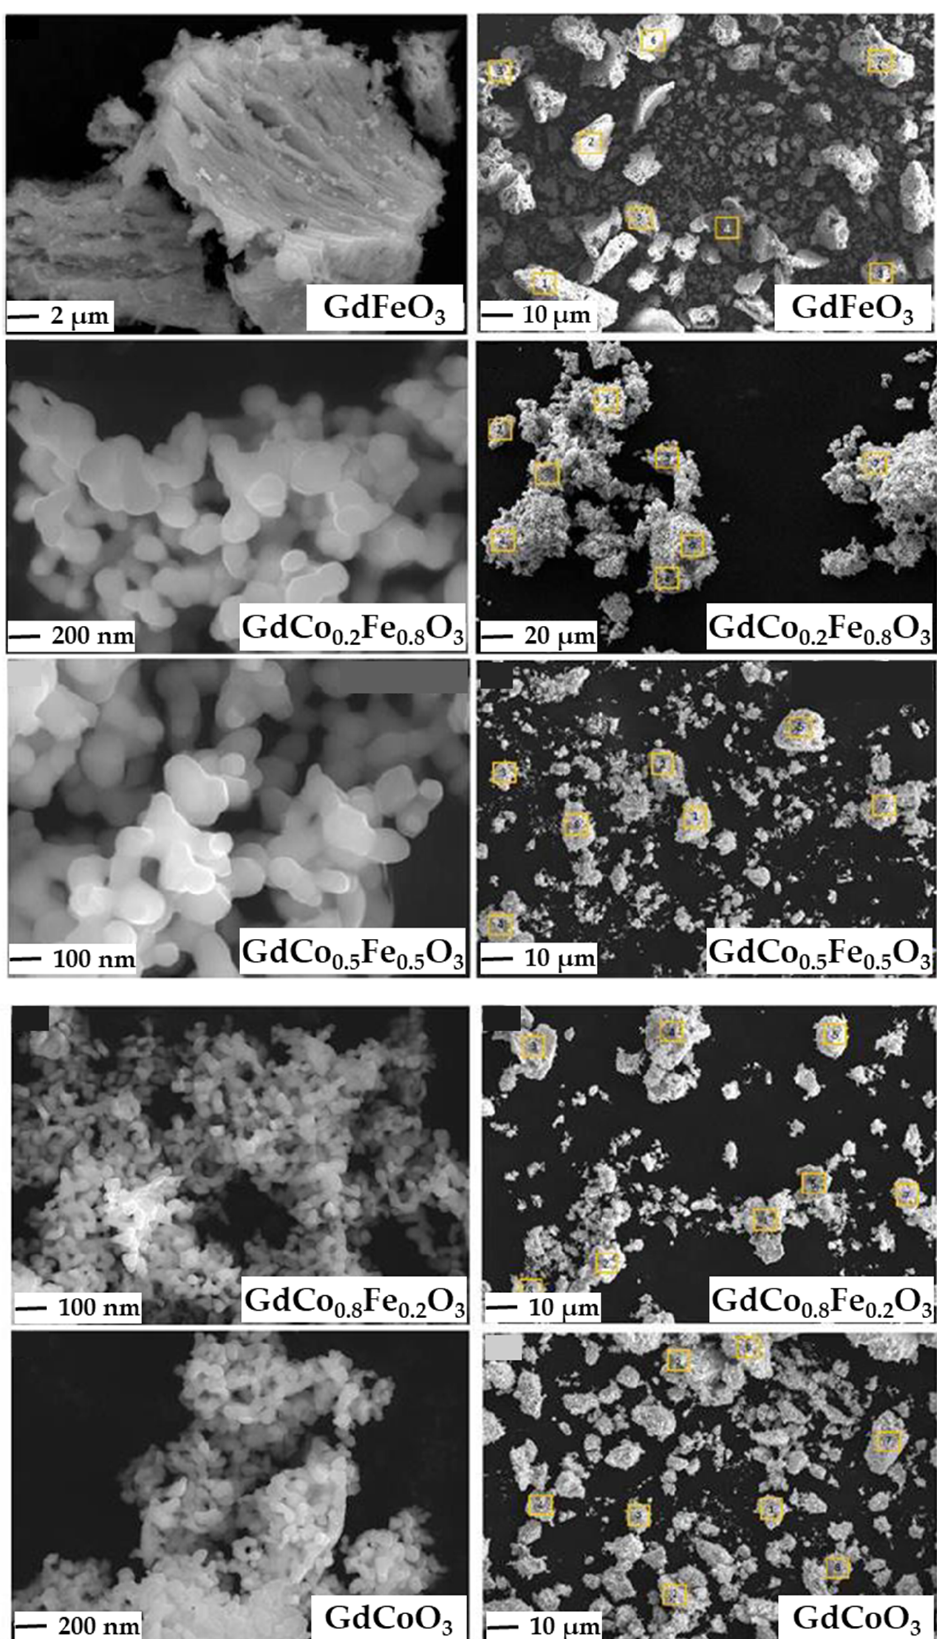
Figure 2. Micrographs of the surface of GdCo x Fe 1 − x O 3 (x = 0; 0.2; 0.5; 0.8; 1).